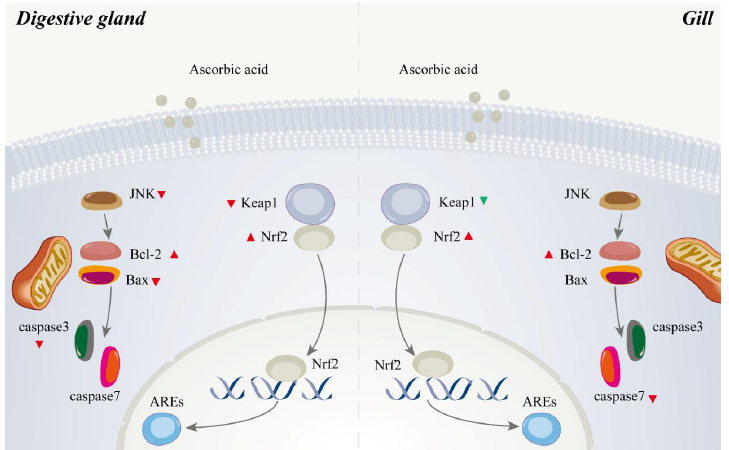
Figure 8. The potential pathway of apoptosis and anti-oxidation in the digestive gland and gill of abalone ( Haliotis discus hannai ) after a 100-day feeding trial. The upregulated and downregulated genes are marked by flammulated up-triangle and down-triangle, respectively. The green up- triangle and green down-triangle indicate the increasing and decreasing trend of the genes, but their expression levels were not